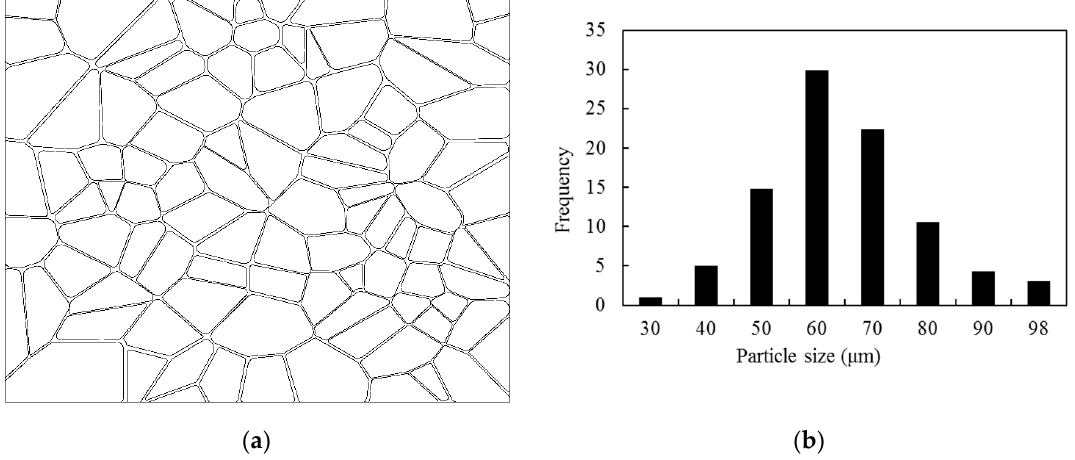
Figure 7. Microstructure of a polymer-bonded explosive (PBX), ( a ) a Voronoi tessellation model, and ( b ) the particle size distribution.